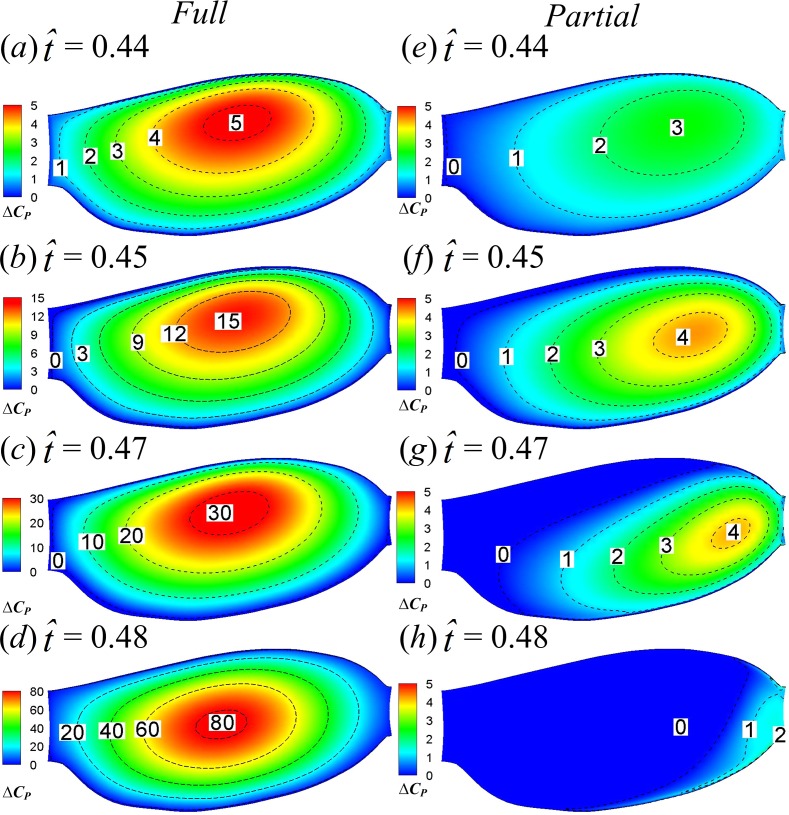
Lower-surface pressure differences between the two two-winged cases and the single-winged case at \documentclass[12pt]{minimal}
\usepackage{amsmath}
\usepackage{wasysym}
\usepackage{amsfonts}
\usepackage{amssymb}
\usepackage{amsbsy}
\usepackage{upgreek}
\usepackage{mathrsfs}
\setlength{\oddsidemargin}{-69pt}
\begin{document}
}{}$\hat {t}=0.44$\end{document}t ˆ=0.44, 0.45, 0.47 and 0.48 in the clap phase.